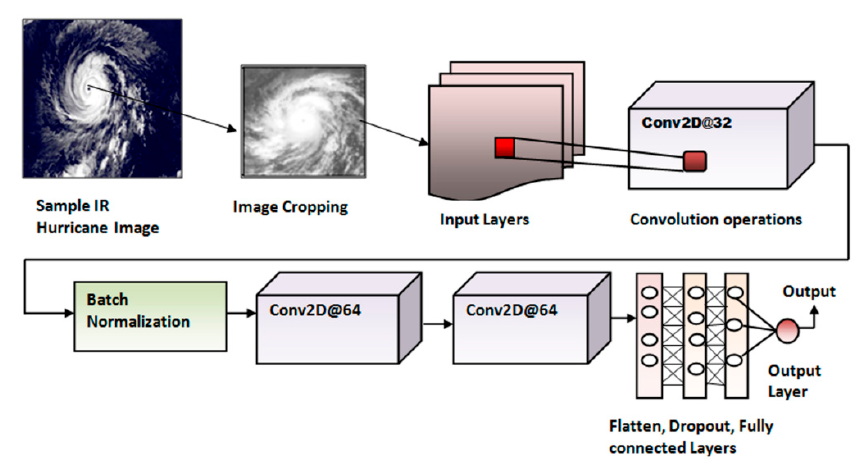
Figure 6. Architecture diagram for hurricane intensity estimation using improved CNN.